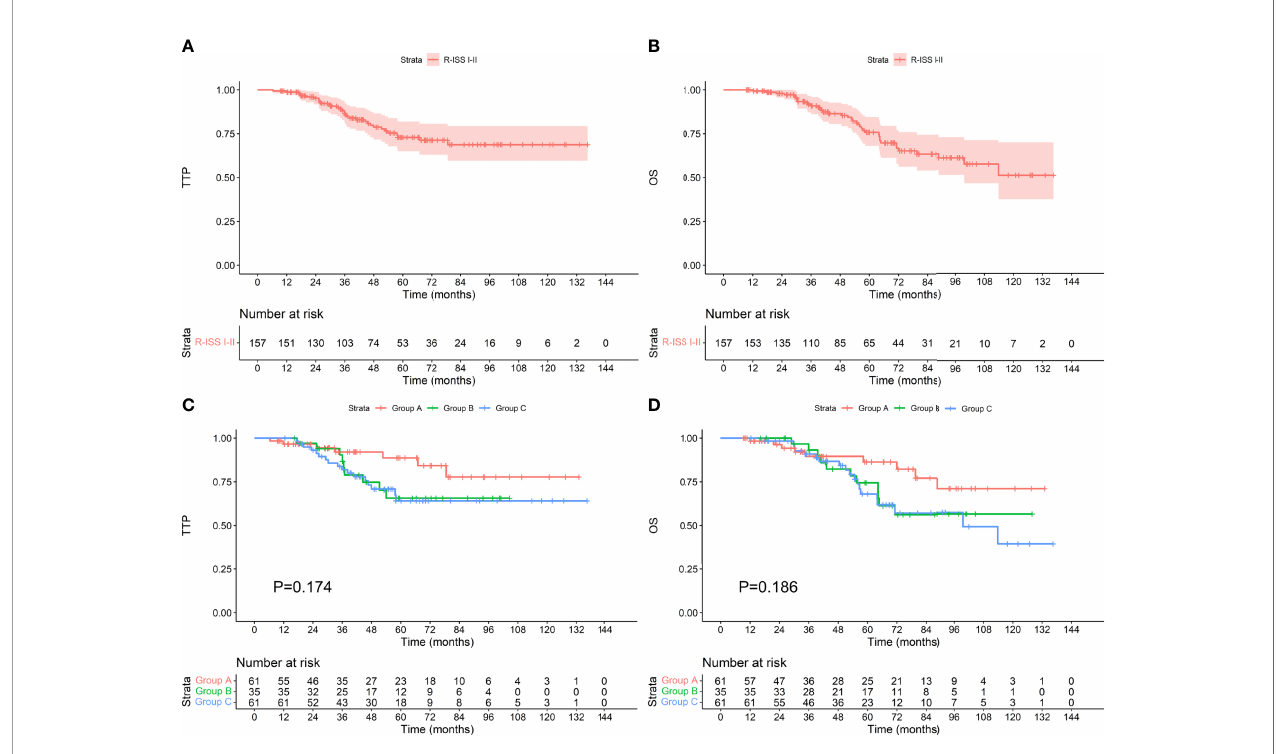
FIGURE 6 | TTP (A) and OS (B) for patients with R-ISS stage I-II and TTP (C) and OS (D) for patients who achieved an MRD-negative status at different stages.